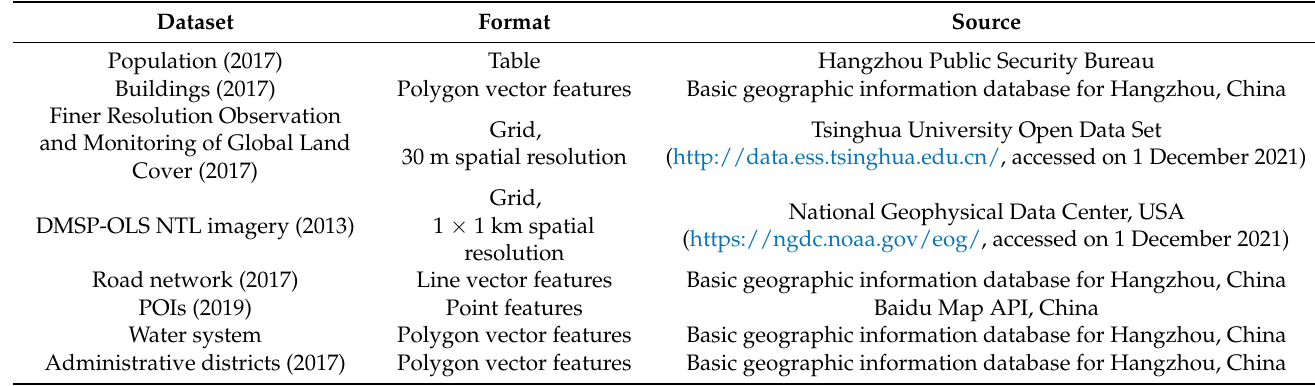
Table 1. Datasets used in the study